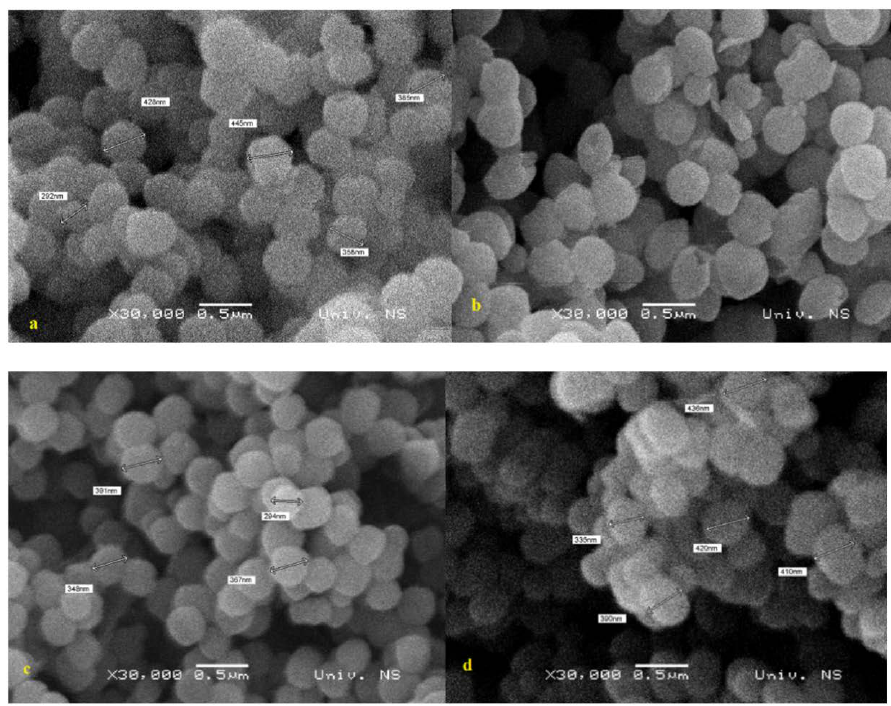
Figure 4. SEM images of the functionalized mesoporous silica particles: A-10-co-cond ( a ), A-15-co- cond ( b ), A-10-PG ( c ), and A-15-PG ( d )